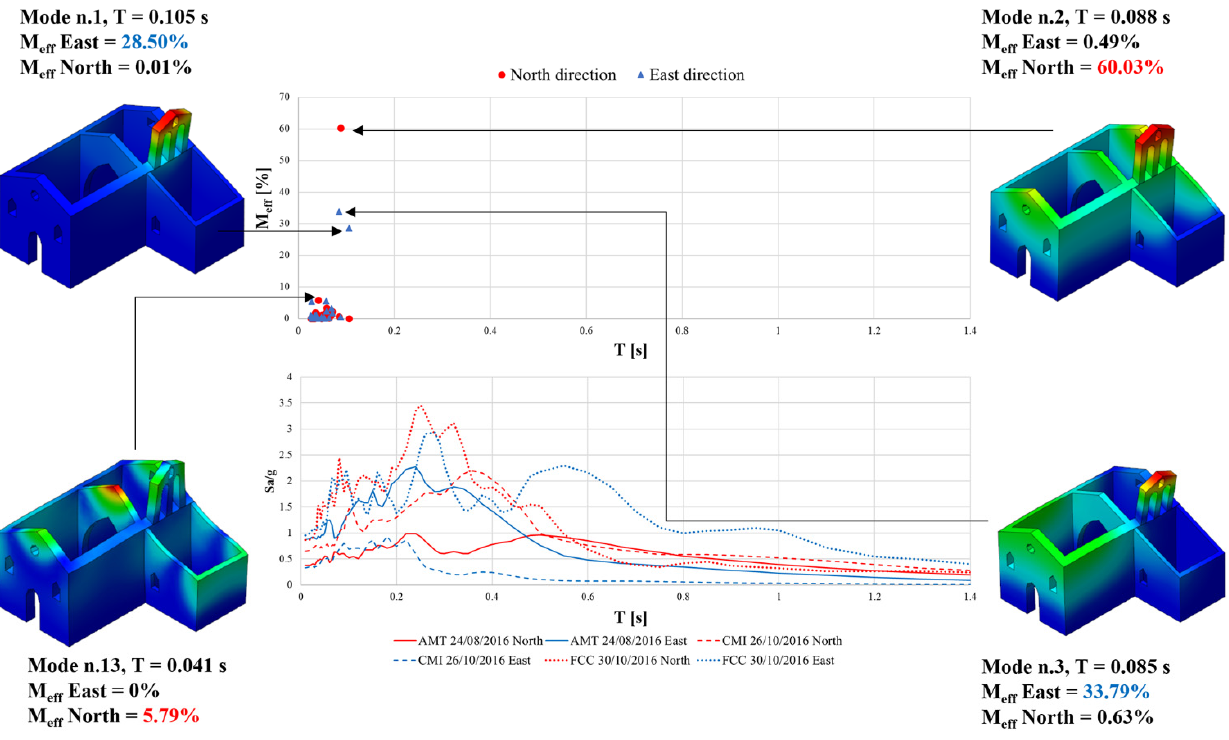
Figure 8. Distribution of modal shapes in the longitudinal and transversal directions and comparison with the pseudo- acceleration response spectra of the three main shocks of Central Italy seismic sequence of 2016 for Madonna of Sant’Antonio Church in Ussita (Macerata, Central Italy).